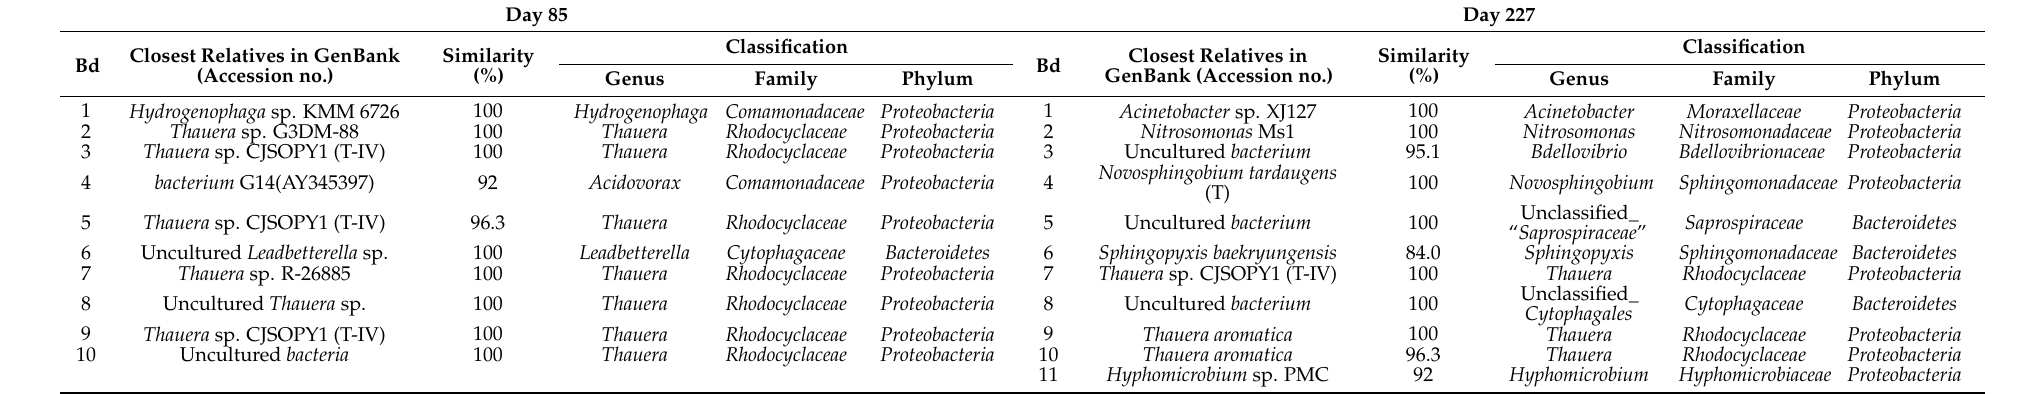
Table 1. DGGE band sequencing analysis on day 85 and